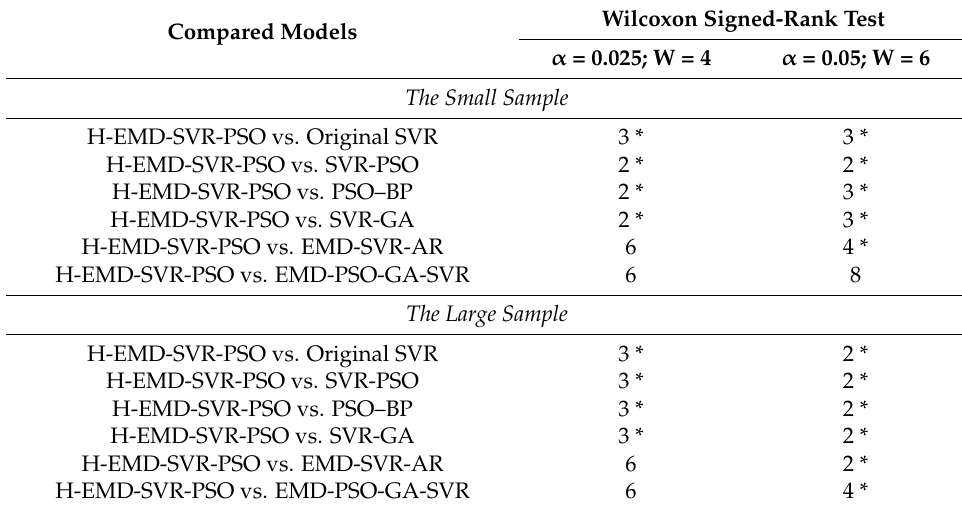
Table 4. Wilcoxon signed-rank